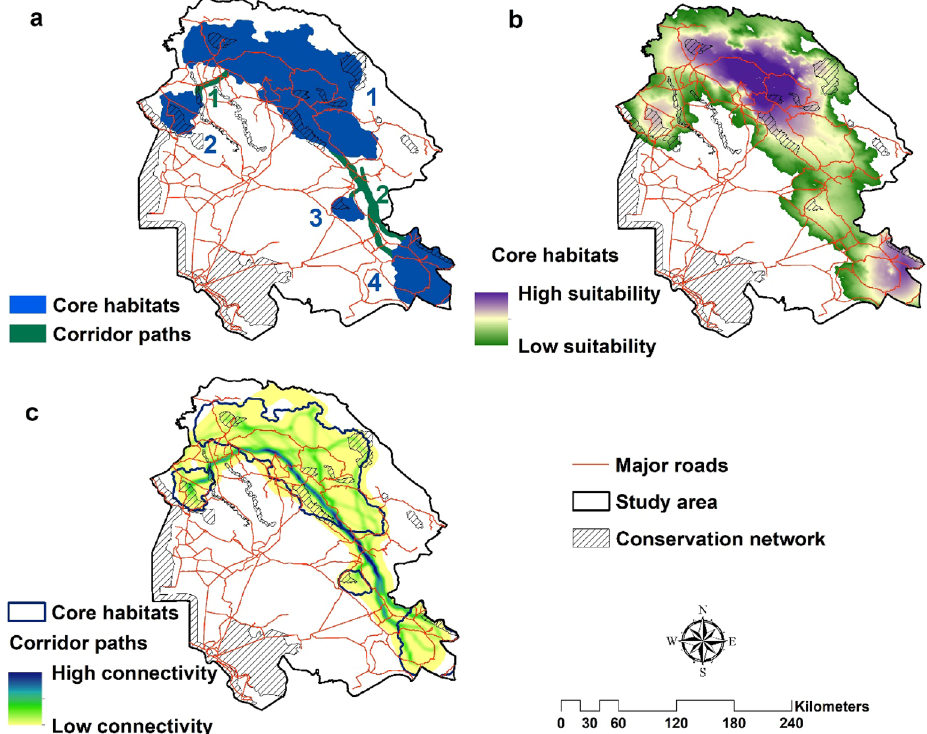
Figure 4. Core habitat and corridors for the striped hyaena in the study area (a: Categorical core habitats and corridor paths, b: Contiguous core habitats and c: Contiguous corridor paths). ArcGIS software version 10.1 (https:// www. esri. com/ en- us/ arcgis/ produ cts/ arcgis- pro/ resou rces) and UNICOR software version 1.0 (https:// www. fs. usda. gov/ trees earch/ pubs/ 40,686) were used to generate the figure.